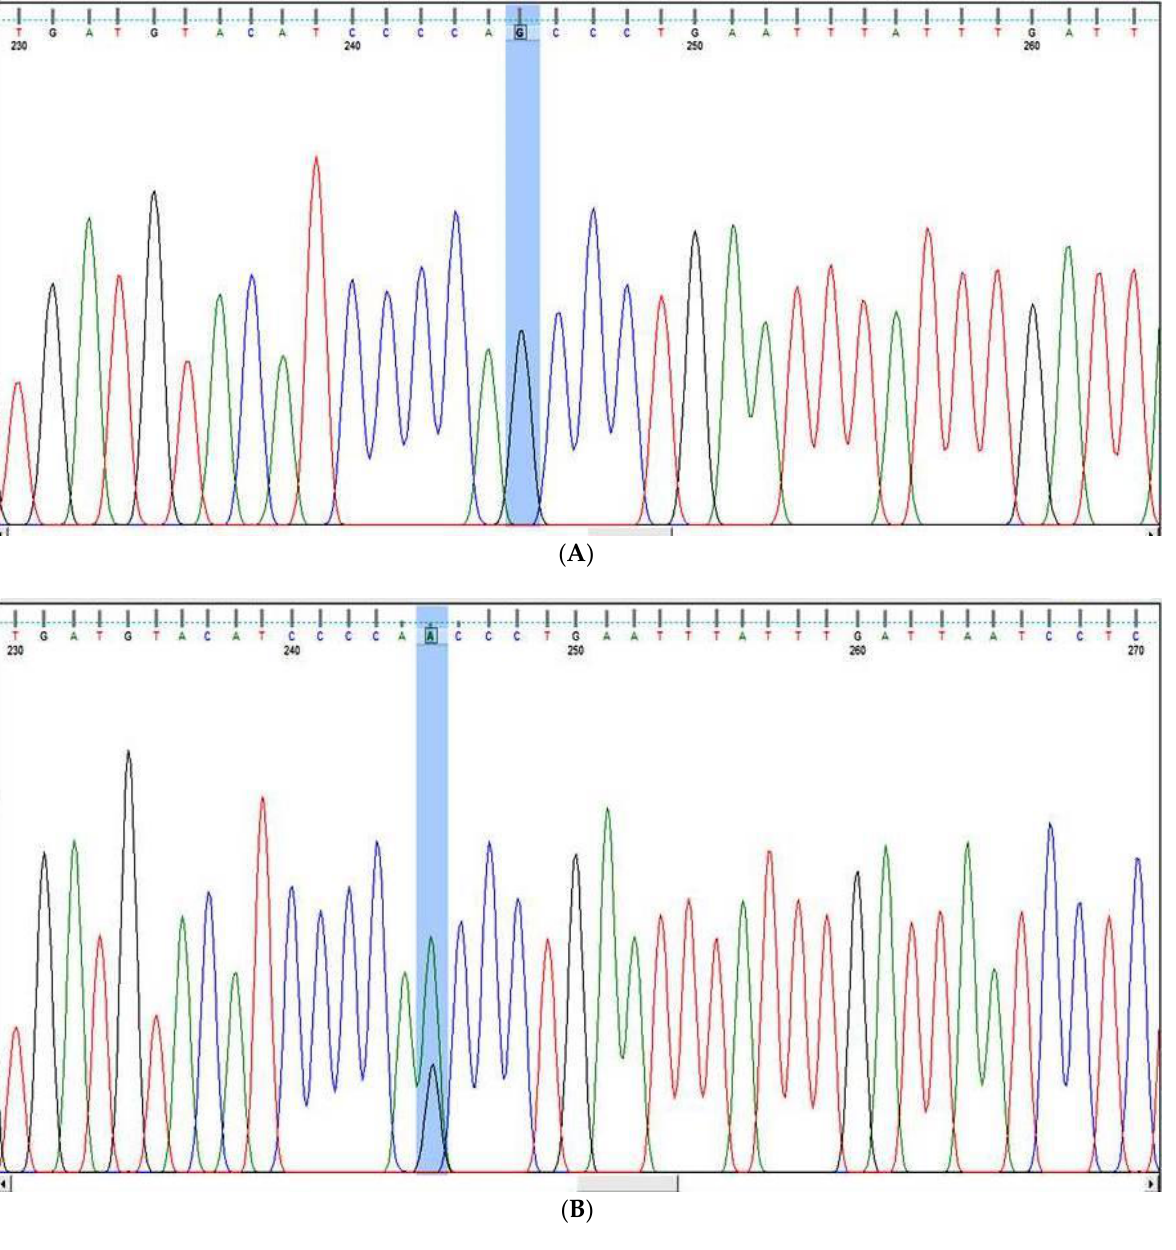
Figure 3. MDM4 rs11801299 A > G genotyping by Sanger sequencing. ( A , B ) Sanger sequencing for MDM4 rs11801299 gene polymorphism (G allele) and AG